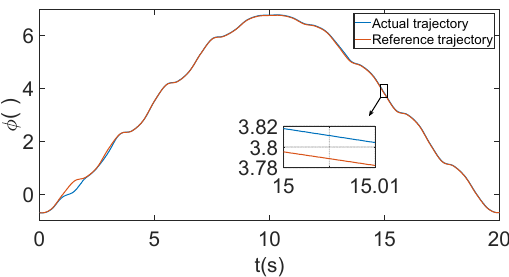
Figure 15. Yaw angle tracking result by LADRC controller.